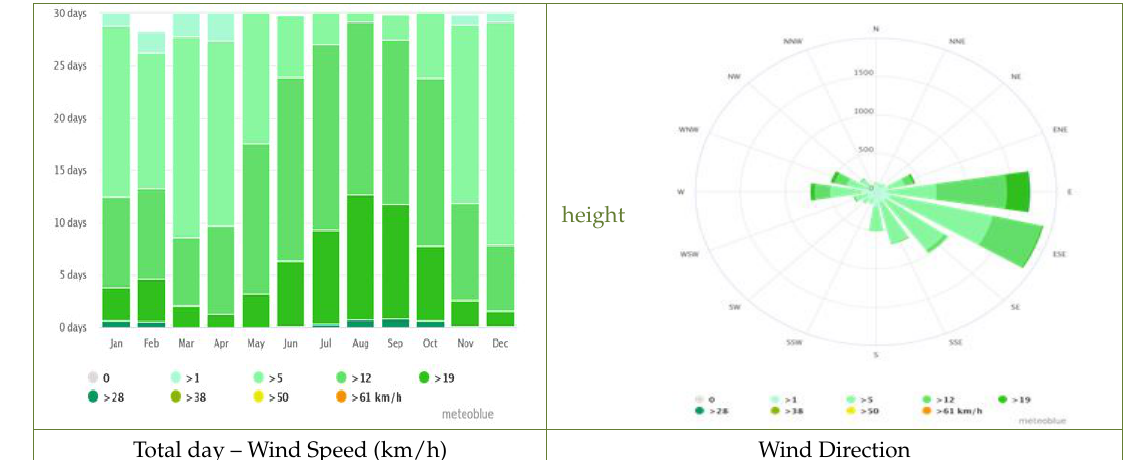
Table 1. Total day count with a certain wind speed and direction database for Surabaya [10]